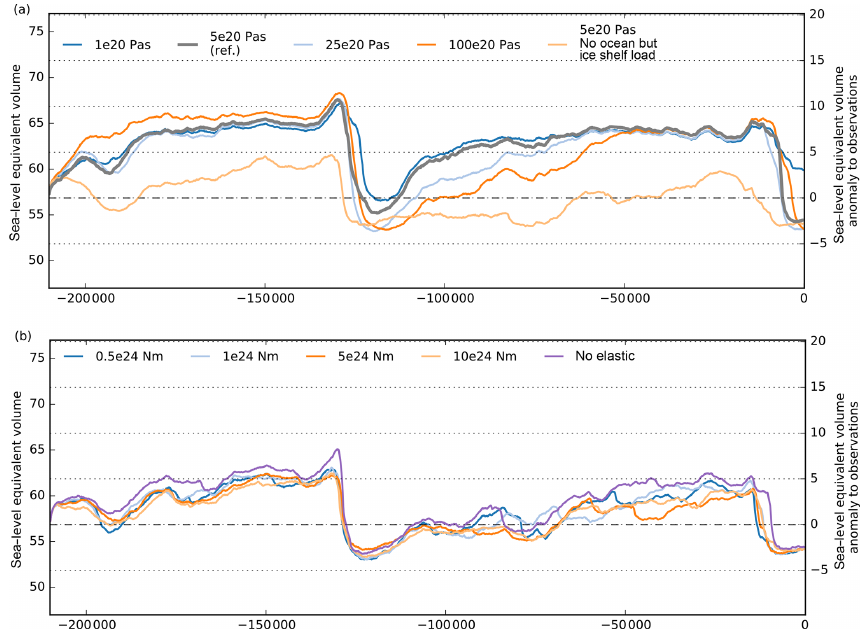
Figure 7. Simulations over two last glacial cycles, with varying Earth model parameters for the viscous and the elastic part. (a) Mantle viscosities with a range over 2 orders of magnitude cause slower ice sheet growth but faster decay for increasing viscosity. (b) The tested flexural rigidity over a range of more than 1 order of magnitude yields smaller difference in simulated ice volume response but increased variability. Be aware that for (b) a different PISM v1.1 was used, with a fixed elastic model, but only accounting for changes in grounded ice loads, explaining generally lower glacial volumes than in the reference in (a)